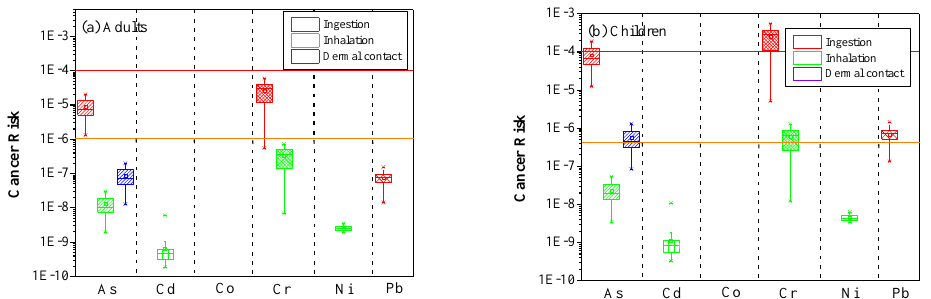
Figure 6. Cancer risk (CR) values of selected heavy metals in household dust in Asaluyeh for adults ( a ) and children ( b ), and for the three pathways (ingestion, inhalation and dermal contact). The orange and red lines denote the lower and upper safe limits, respectively.